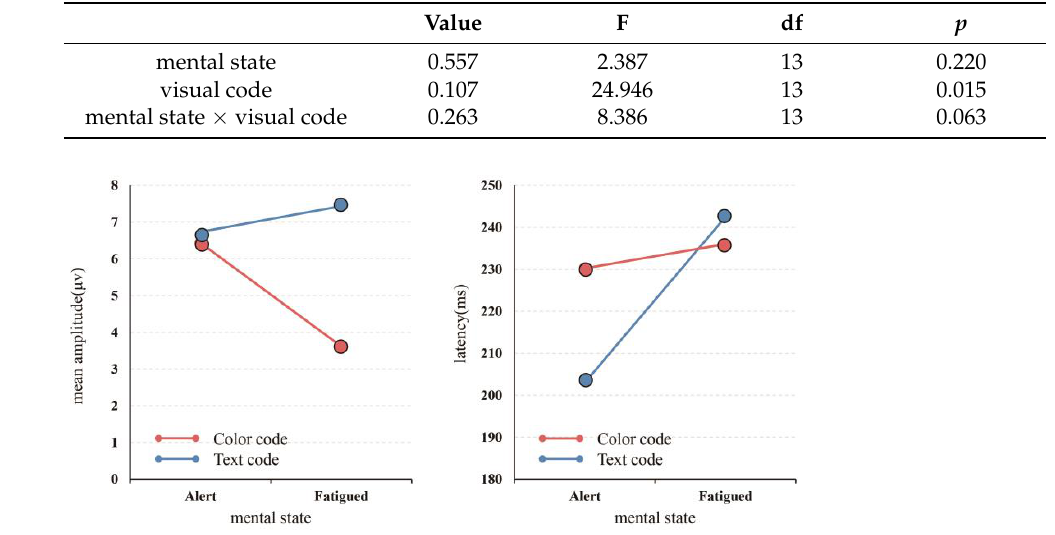
Table 7. Multivariate ANOVA results for P200 latency of mental state and visual code.